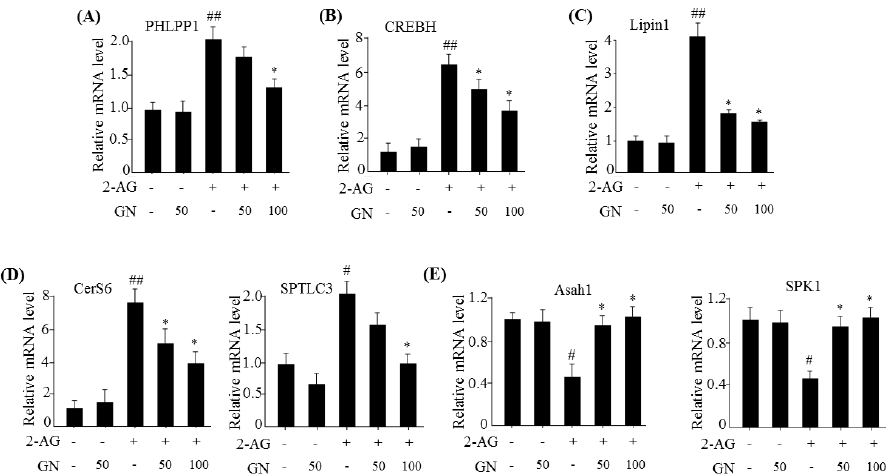
Figure 2. GN reversed 2-AG-mediated expression of insulin resistance-associated genes in HepG2 cells. HepG2 cells were incubated with 2-AG in the absence or presence of GN (50 or 100 µM) for 12 h. qPCR analysis of PHLPP1 ( A ), CREBH ( B ), Lipin1 ( C ), Cer6 and SPTLC3 ( D ), and Asah1 and SPK1 ( E ). Values are expressed as mean ± SEM ( n = 3 independent experiments). # p < 0.05, ## p < 0.01 vs. untreated control. * p < 0.05 vs. 2-AG-treated control.